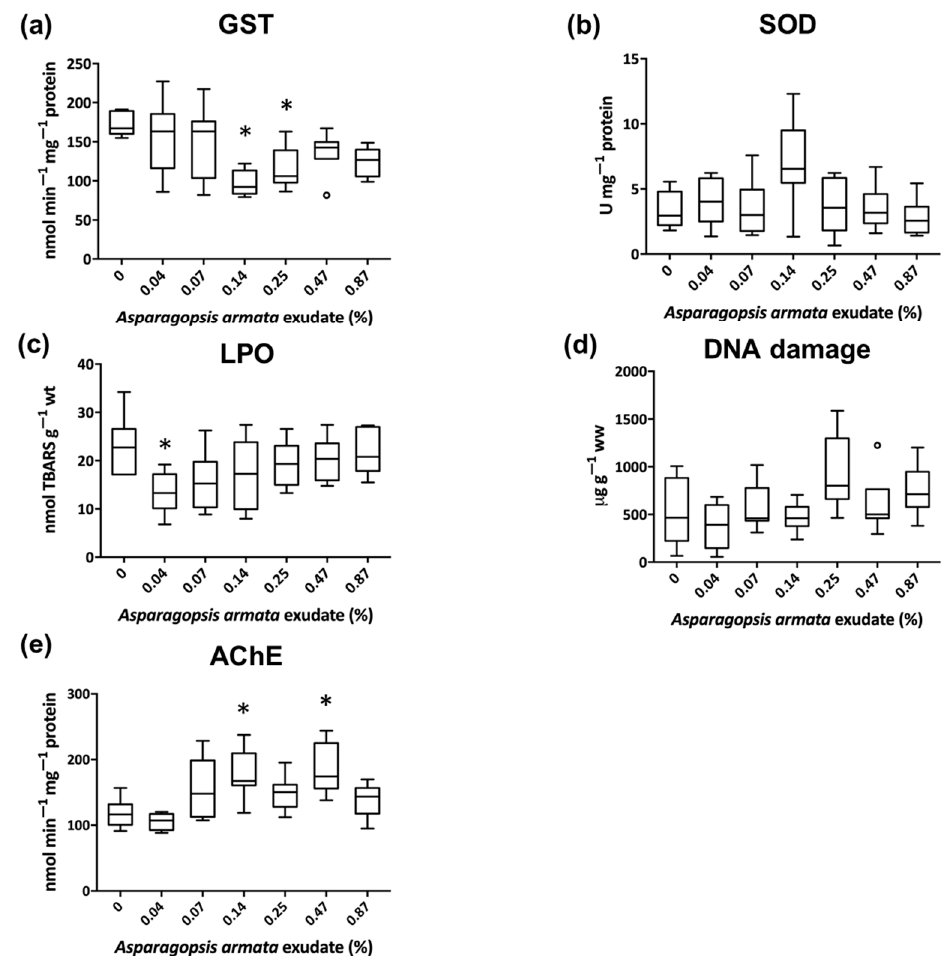
Figure 1. Results of detoxification and antioxidant defenses ( a , b ), oxidative damage ( c , d ), and acetylcholinesterase ( e ) biomarkers in Gibbula umbilicalis’ whole body when exposed to Asparagopsis armata exudate for 168 h ( n = 8, pools of 2 individuals). Results are shown in boxplot (i.e., the median, the first and the third quartiles, and the nonoutliers’ range and the outliers); * Significant differences from the control (Kruskal–Wallis test, Nemenyi post hoc test, p < 0.05).